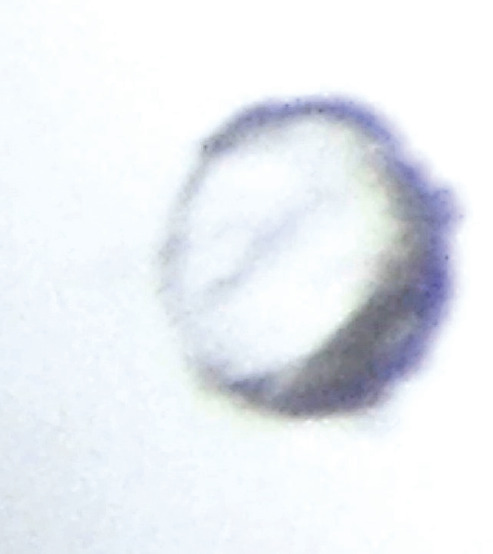
Leucocyte, negative for carcinoembryonic antigen (red) and positive for membrane CD45 (brown).